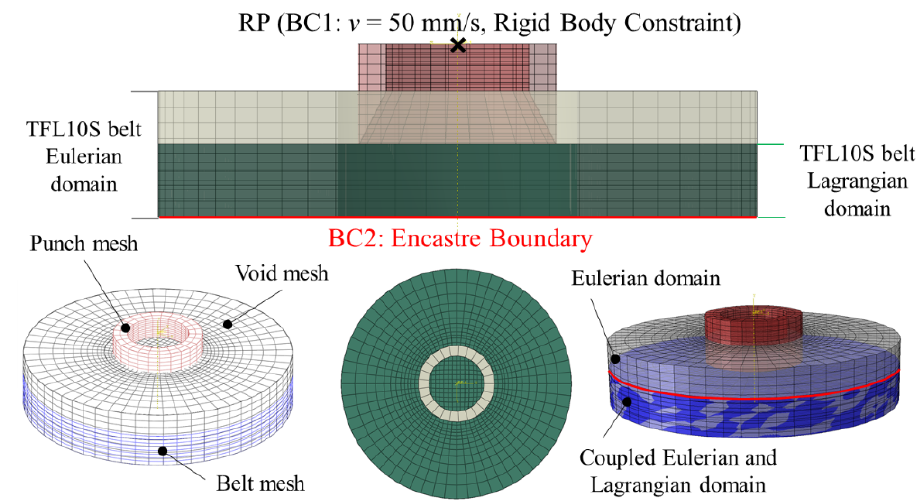
Figure 9. The construction of the FEM model in Abaqus using CEL method. Table 1. Material properties used in FEM modelling of the TFL10 belt.